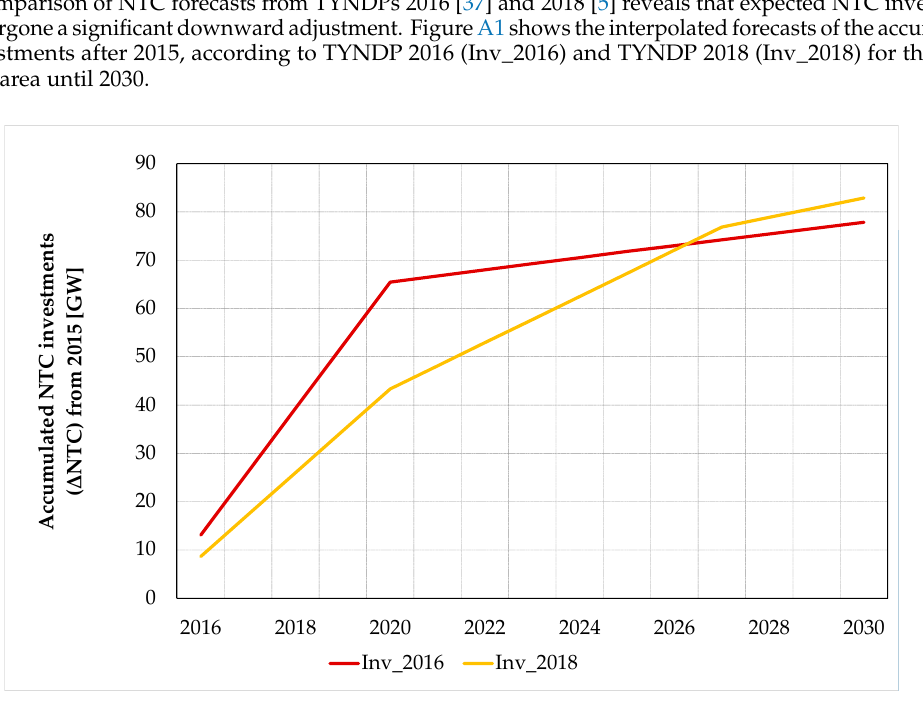
Figure 13. Accumulated NTC investments in the ENTSO-E area [5,37]. Figure A1. Accumulated NTC investments in the ENTSO-E area